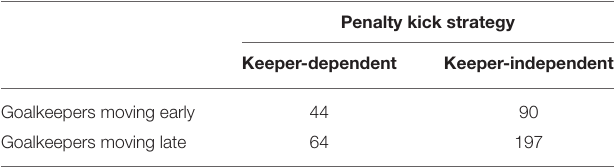
TABLE 2 | Distributions of goalkeeper strategies (moving early or late) and penalty kick strategy (keeper-dependent,